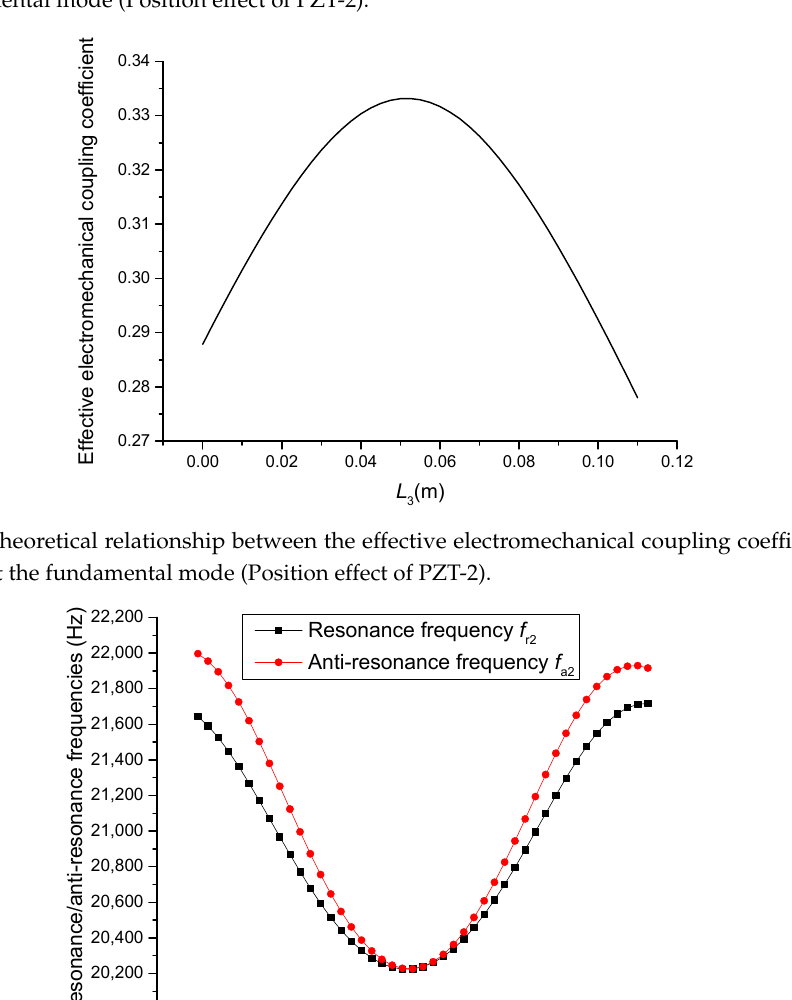
L 3 (m) Figure 10. Theoretical relationship between the effective electromechanical coupling coefficient and length L 3 at the second mode (Position effect of PZT-2). As can be seen from Figures 7 and 8, the performance parameters of the cascaded piezoelectric ultrasonic transducer change when the position of piezoelectric ceramic stacks PZT-2 changes at the fundamental mode. When the length L 3 is increased, the resonance/anti-resonance frequencies and the effective electromechanical coupling coefficient are significantly increased. However, when the PZT-2 is in the middle position, there is a maximum value for the resonance/anti-resonance frequencies and the effective electromechanical coupling coefficient, which is the design goal of the transducer. As can be seen from Figures 9 and 10, when the PZT-2 is in a certain position, the resonance/anti-resonance frequencies and the effective electromechanical coupling coefficient appear to be a minimum value at the second mode. There is avoided in the design process of the transducer. 3.2. Position Effect of Piezoelectric Ceramic Stacks PZT-3